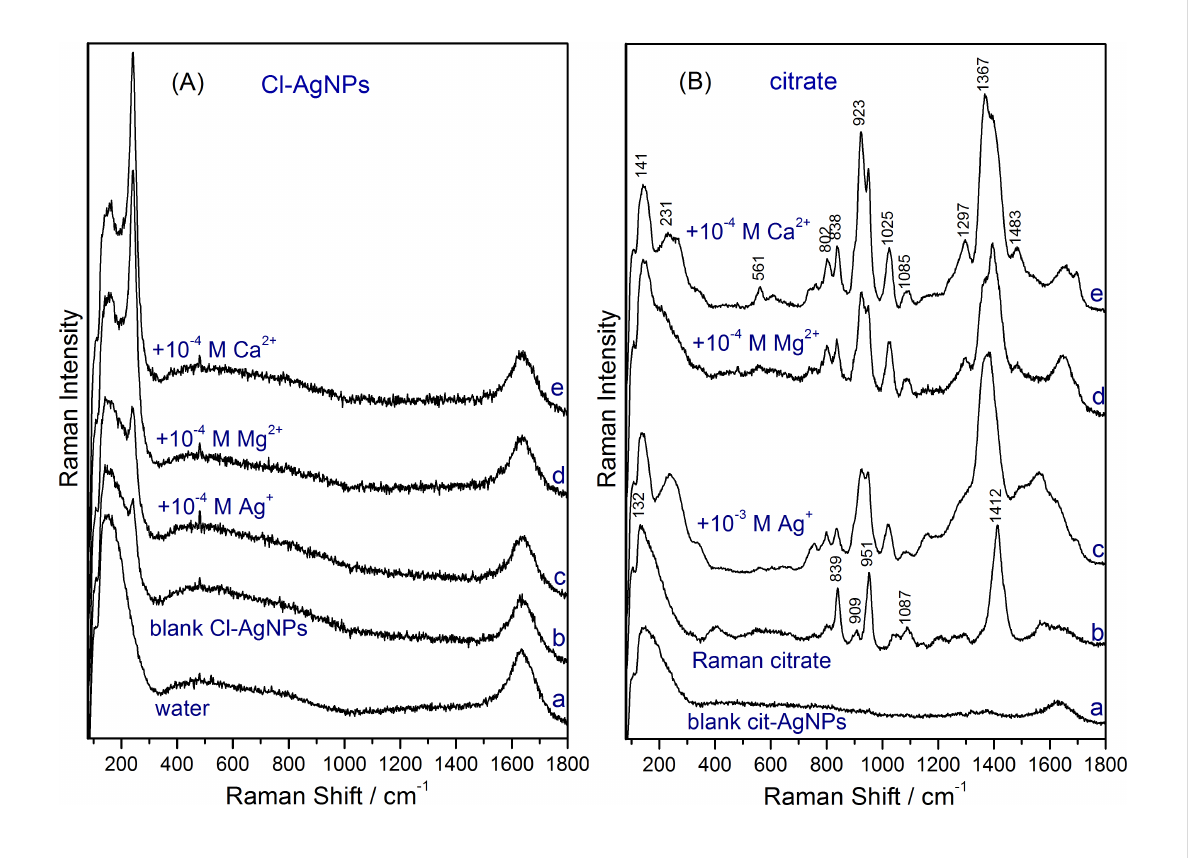
Figure 5: (A) Raman spectrum of water (a), SERS spectrum of Cl-AgNPs (b), SERS spectrum of Cl-AgNPs after addition of 10 − 4 M AgNO 3 (c), 10 − 4 M MgSO 4 (d), and 10 − 4 M Ca(NO 3 ) 2 (e) showing the intense Ag–Cl SERS band. (B) Raman blank spectrum of cit-AgNPs (a), Raman spectrum of 1 M citrate (b), SERS spectra of citrate obtained after addition of 10 − 3 M AgNO 3 (c), 10 − 4 M MgSO 4 (d), and 10 − 4 M Ca(NO 3 ) 2 (e) to the